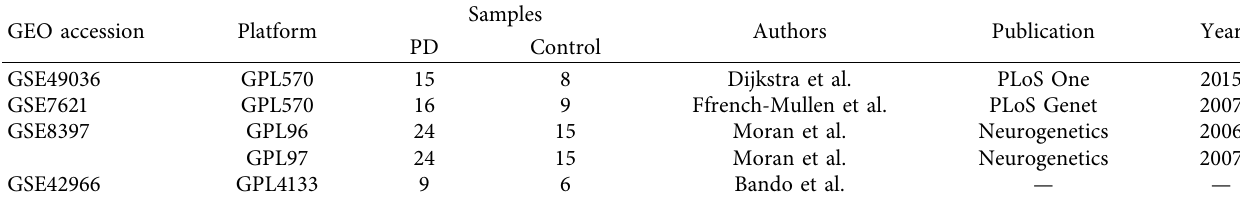
Table 1: Te fundamental information of microarray datasets from